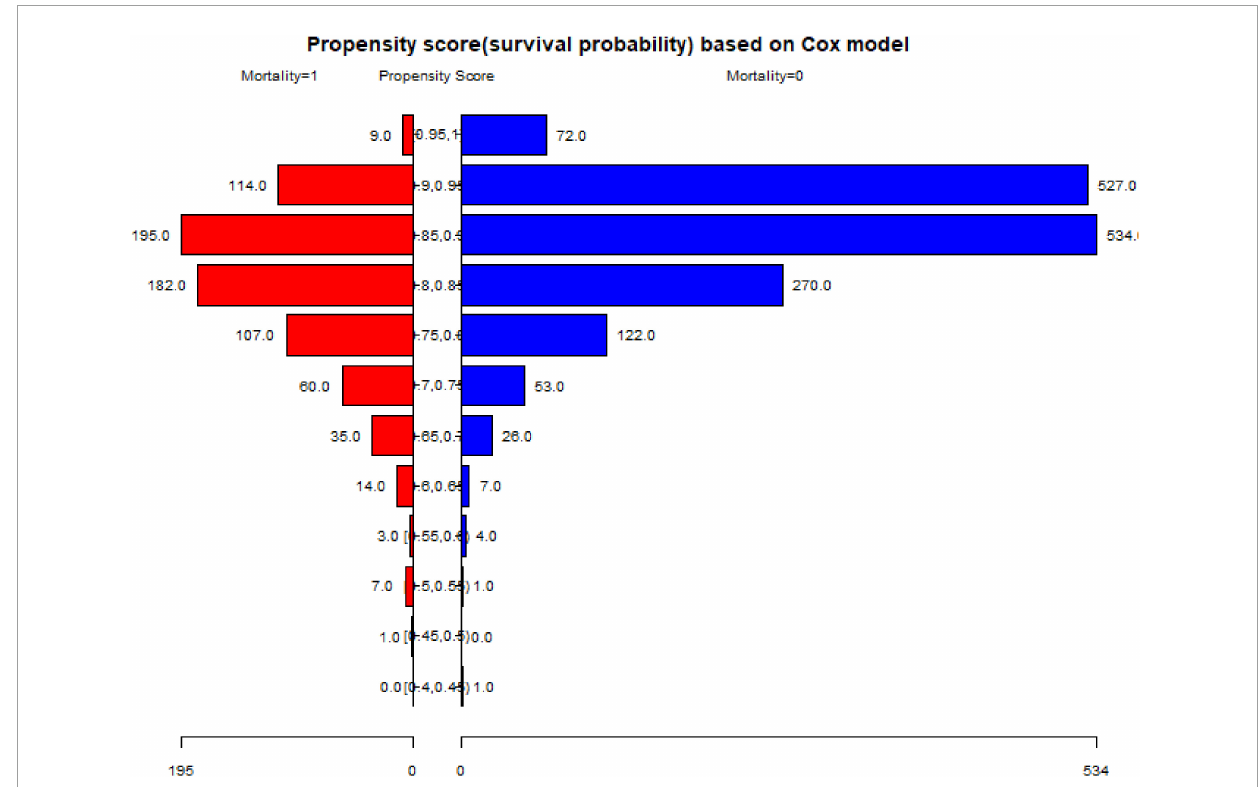
FIGURE2 The PSM of two groups under propensity score based on the Cox